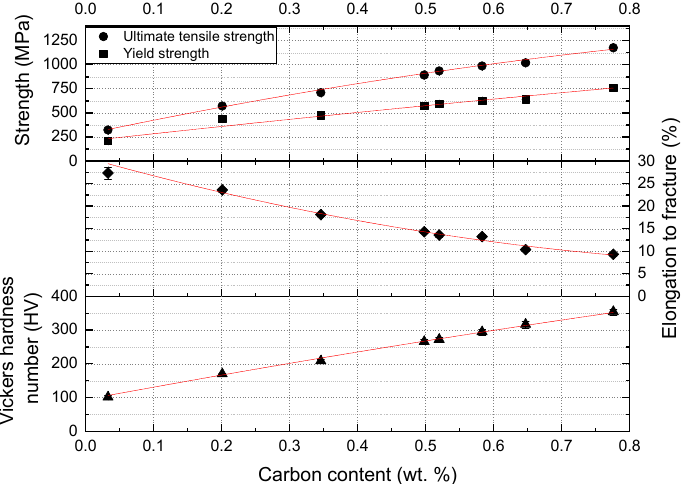
Figure 1. Correlations of tensile properties and Vickers hardness with carbon content of the plain carbon steels of group A.